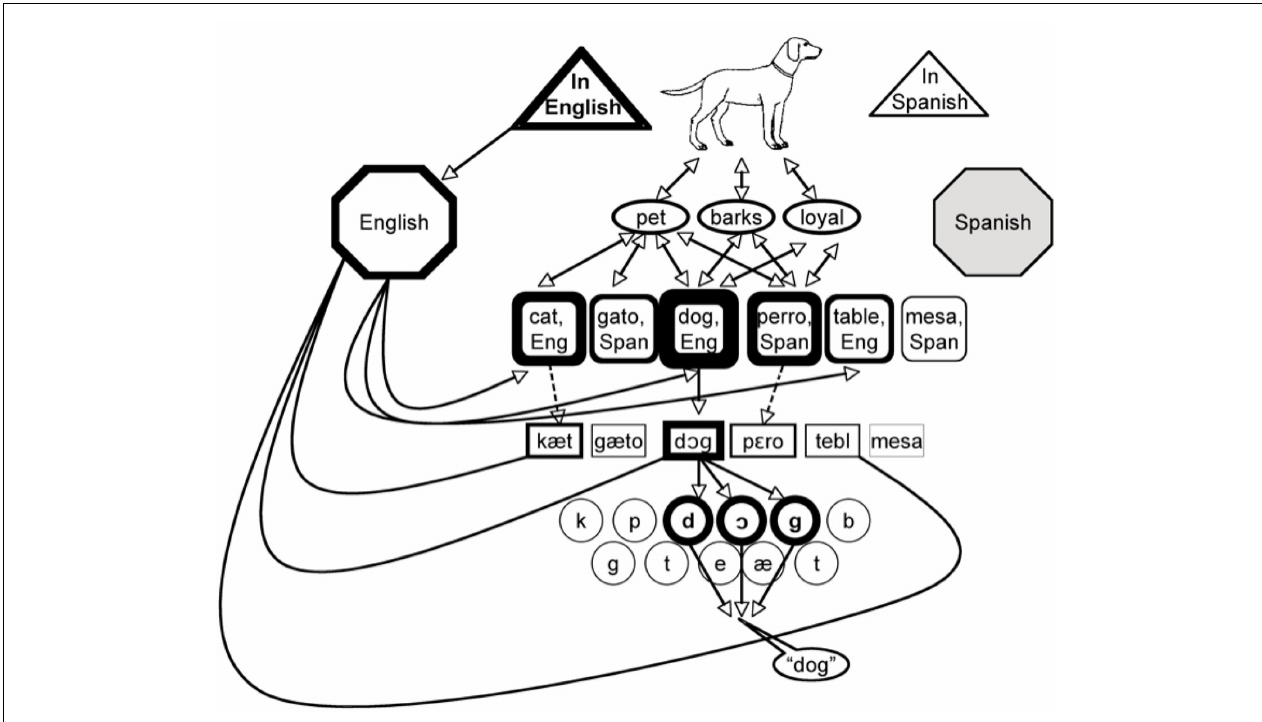
FIGURE 7 |A schematic illustration of de Bot’s (2004) multilingual processing model. When a speaker intends to name in English, Spanish nodes may receive activation and do compete for selection. However, the speaker’s intention biases activation such that target language nodes are always more active than their